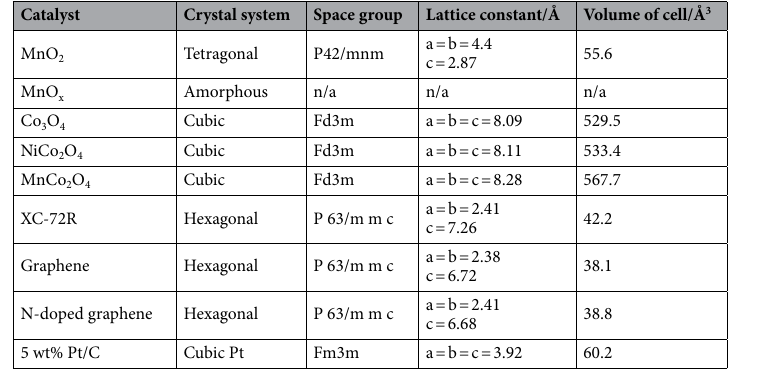
Table 1. Summary of XRD structures from Fig.